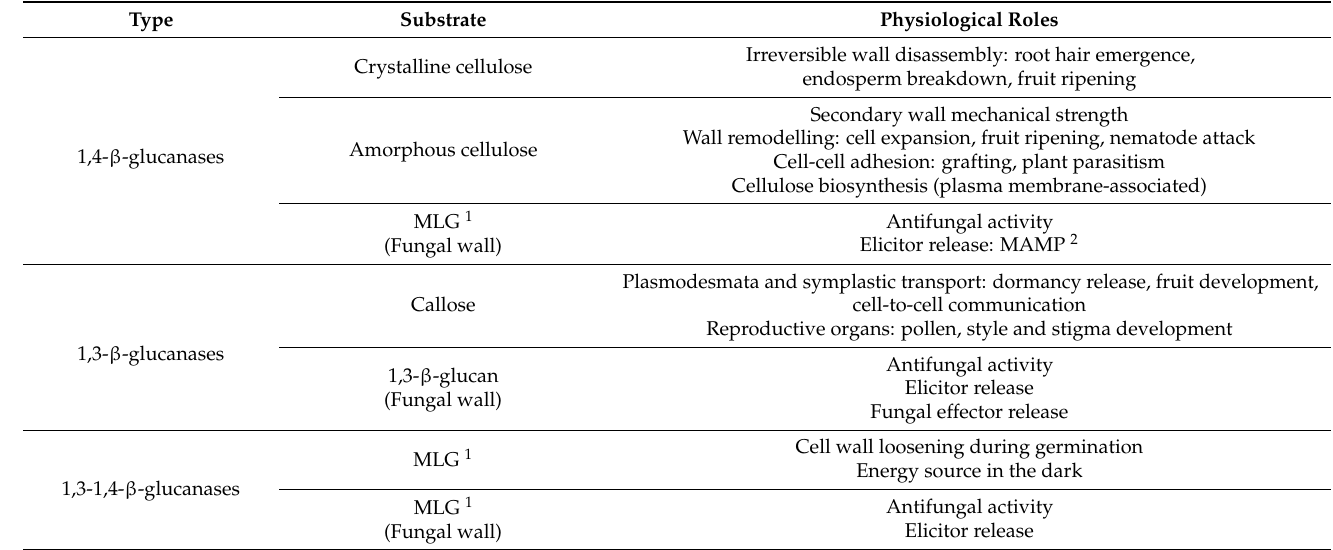
Table 1. Proposed physiological roles of plant β